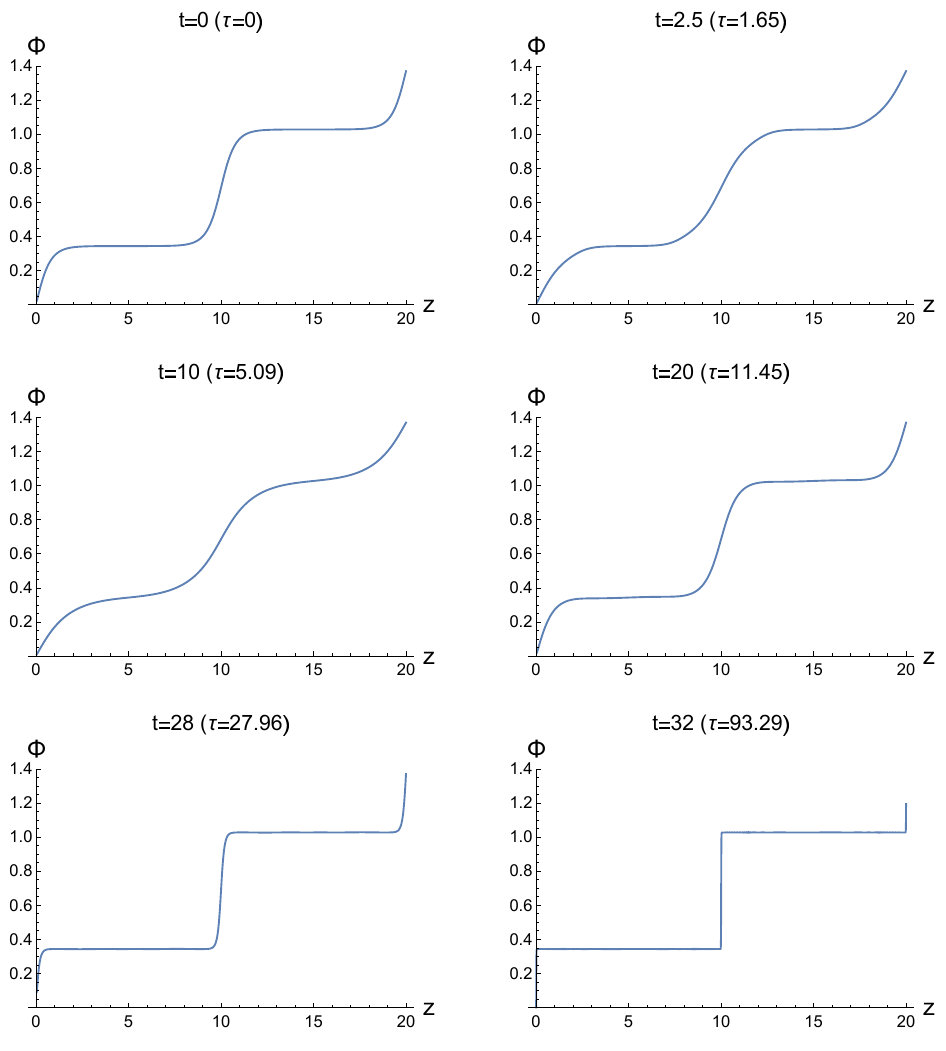
Figure 4 . The profiles of Φ at various times. The parameters are chosen as (4.6) and V min = 0